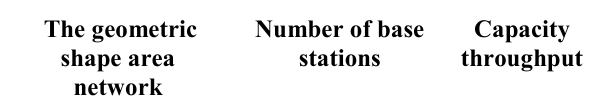
Table 3. Influence of network geometry on